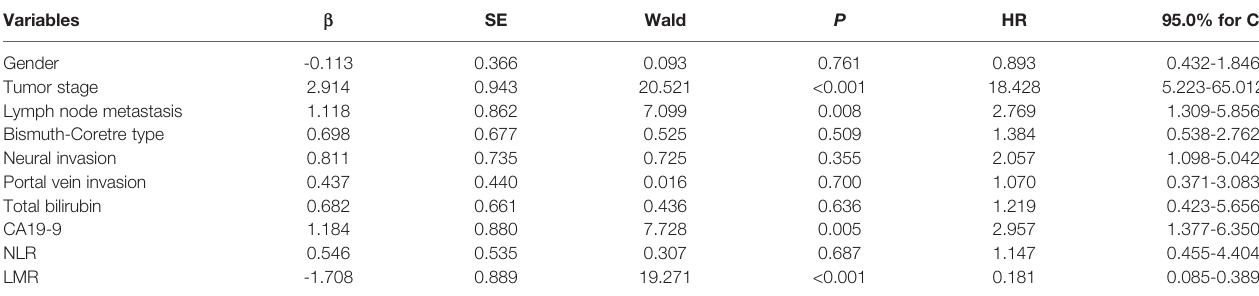
TABLE 4 | Multivariable analysis for overall